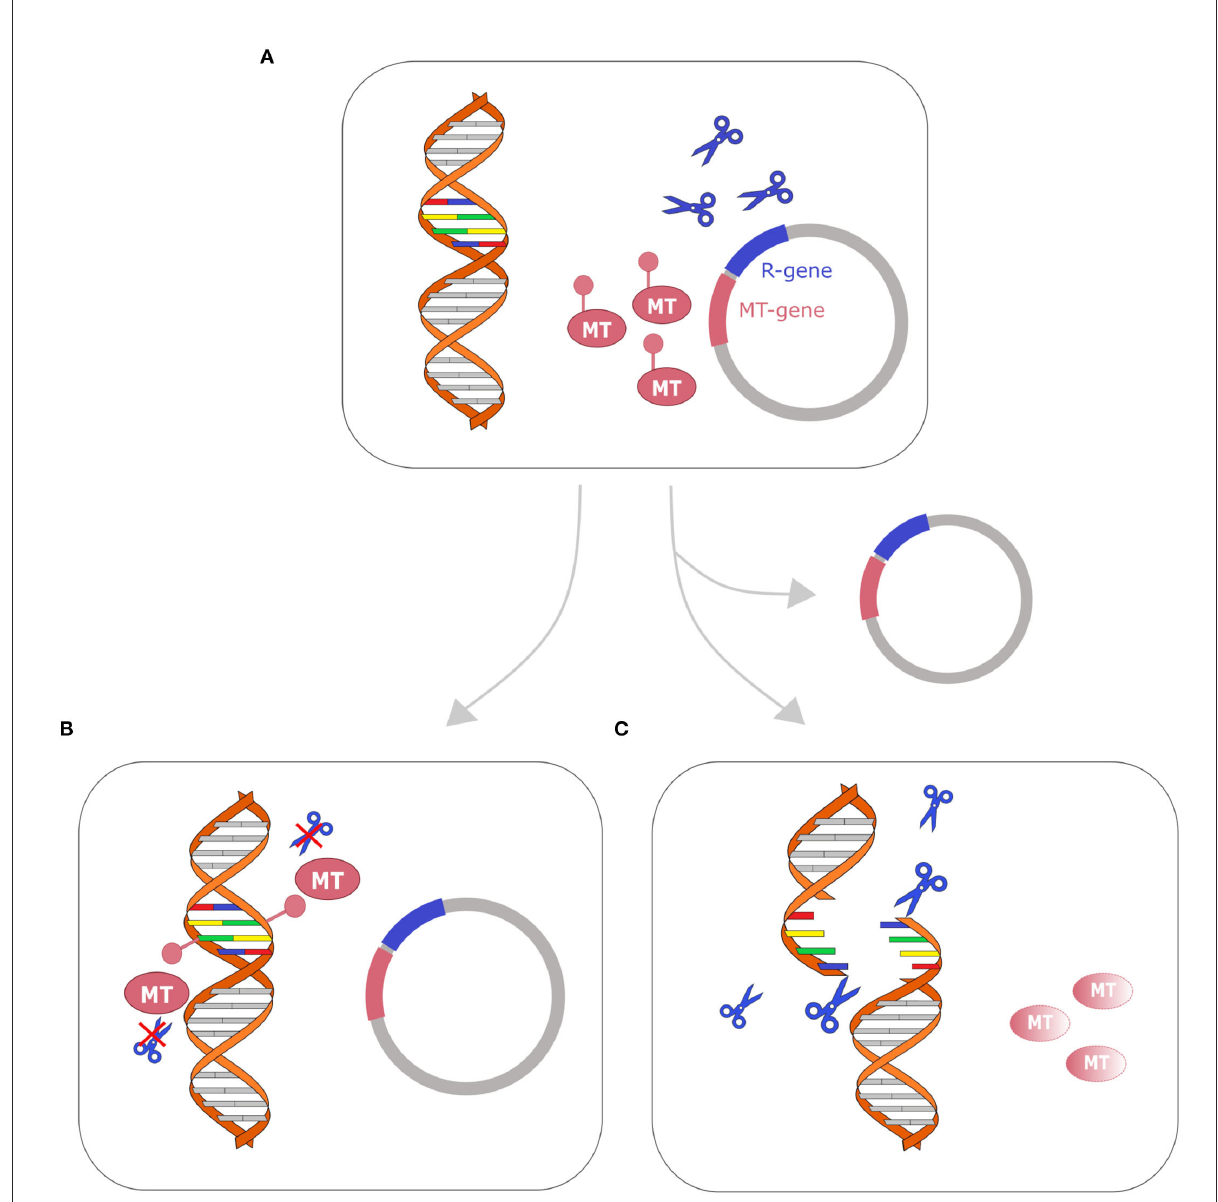
FIGURE3 Restriction-modification system as a toxin–antitoxin system. Cell with plasmid that encodes R-M genes toxin–antitoxin system is represented on the top (A) . After replication, two fates are possible: (B) if the cell retains the plasmid (bottom left), the genomic DNA is methylated by the methyltransferase (MT) and the restriction enzyme (represented with blue scissors) cannot cleave the DNA; (C) if the cell loses the plasmid, the methyltransferase (MT) is fastly degraded, while the restriction enzyme remains active and cleaves the DNA, leading to cellular death. A similar mechanism has been described in several toxin–antitoxin systems (Kulakauskas et al., 1995; Unterholzner et al., 2013; Mruk and Kobayashi,